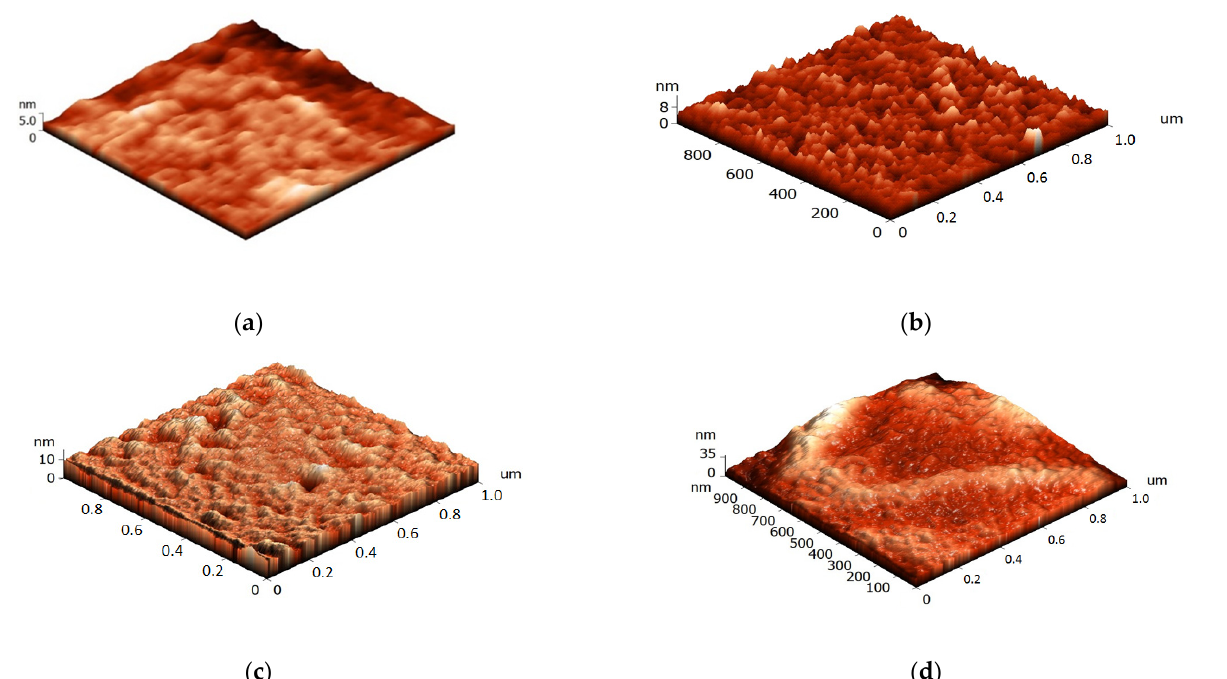
Figure 2. Three-dimensional images of the surface of the chitosan film ( a ) and composite films containing 0.5 ( b ), 1.0 ( c ), 3.0 ( d ) wt.% of SWCNT. Size of the studied surfaces: 1 × 1 µm.